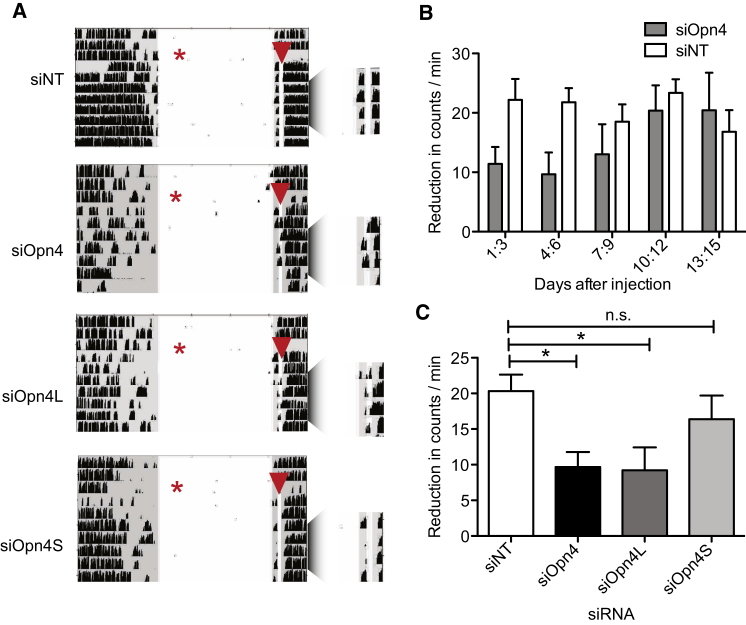
OPN4L Mediates Negative Masking(A) Representative actograms from animals given intravitreal bilateral injection (indicated by a red star) of siNT, siOpn4, siOpn4S, and siOpn4L show negative masking after a 10 min ZT12.5 light pulse (indicated by a red arrow) every day following injection. This protocol avoids significant light-induced phase shifts. Negative masking is attenuated with siOpn4 and siOpn4L. Actograms are enlarged around light pulse for clarity.(B) Histogram of reduction in activity during the light pulse (as compared with activity preceding the light pulse) across 3-day bins as indicated on the y axis.(C) Histogram of reduction in average (of days 2–8) wheel-running activity during the nocturnal light pulse shows smaller reductions in activity with siOpn4 (11.1 ± 1.6 versus 22.2 ± 2.3 siNT) and siOpn4L-treated animals (9.7 ± 3.6). siOpn4S had no significant effect (18.0 ± 3.4). n = 6. ∗p < 0.05; one-way ANOVA with Dunnett’s post-test. Error bars represent the SEM.See also Figures S1–S4.